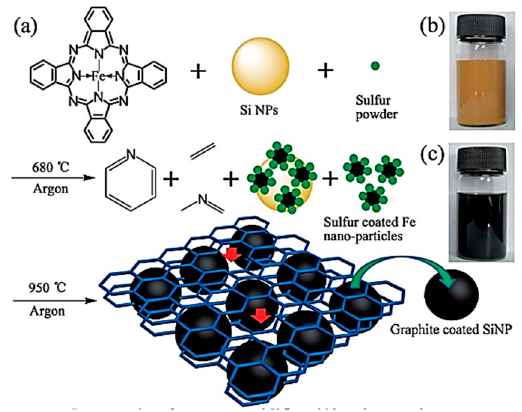
Figure 1. ( a ) Schematic diagram of the formation of the N-doped porous graphene